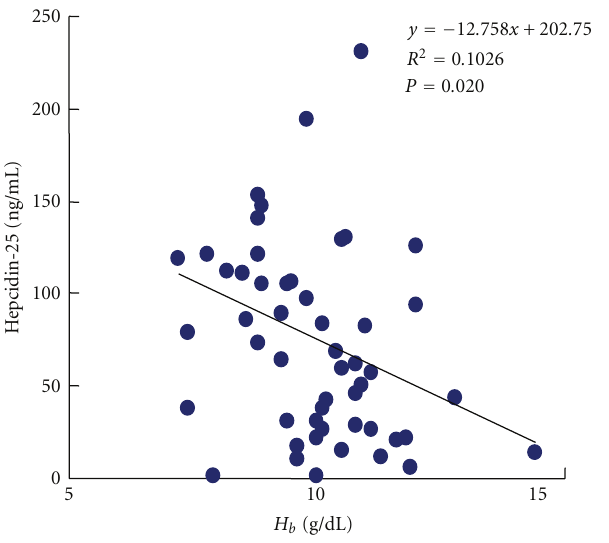
Figure 2: Correlation between serum RET-He and hemoglobin (Hb)